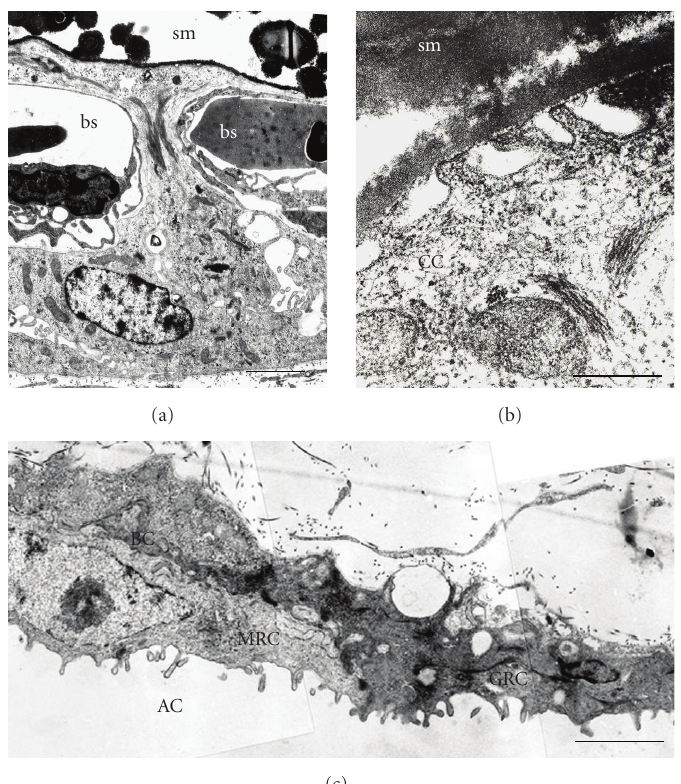
Figure 4: (a) A CC cell shows its typical cytoplasmic lateral projections which separate the shell membrane (sm) from the capillaries of the blood sinus (bs). Original magnification: 11,200x; scale bar: 2 μ m. (b) Apical pits are formed by CC cell membrane adjacent to the inner shell membrane (sm). Original magnification: 70,000x; scale bar: 0.5 μ m. (c) Basal cells (BC), mitochondria-rich cells (MRC), and granule-rich cells (GRC) characterize the CAM allantoic epithelium which faces the allantoic cavity (AC). Original magnification: 21,700x; scale